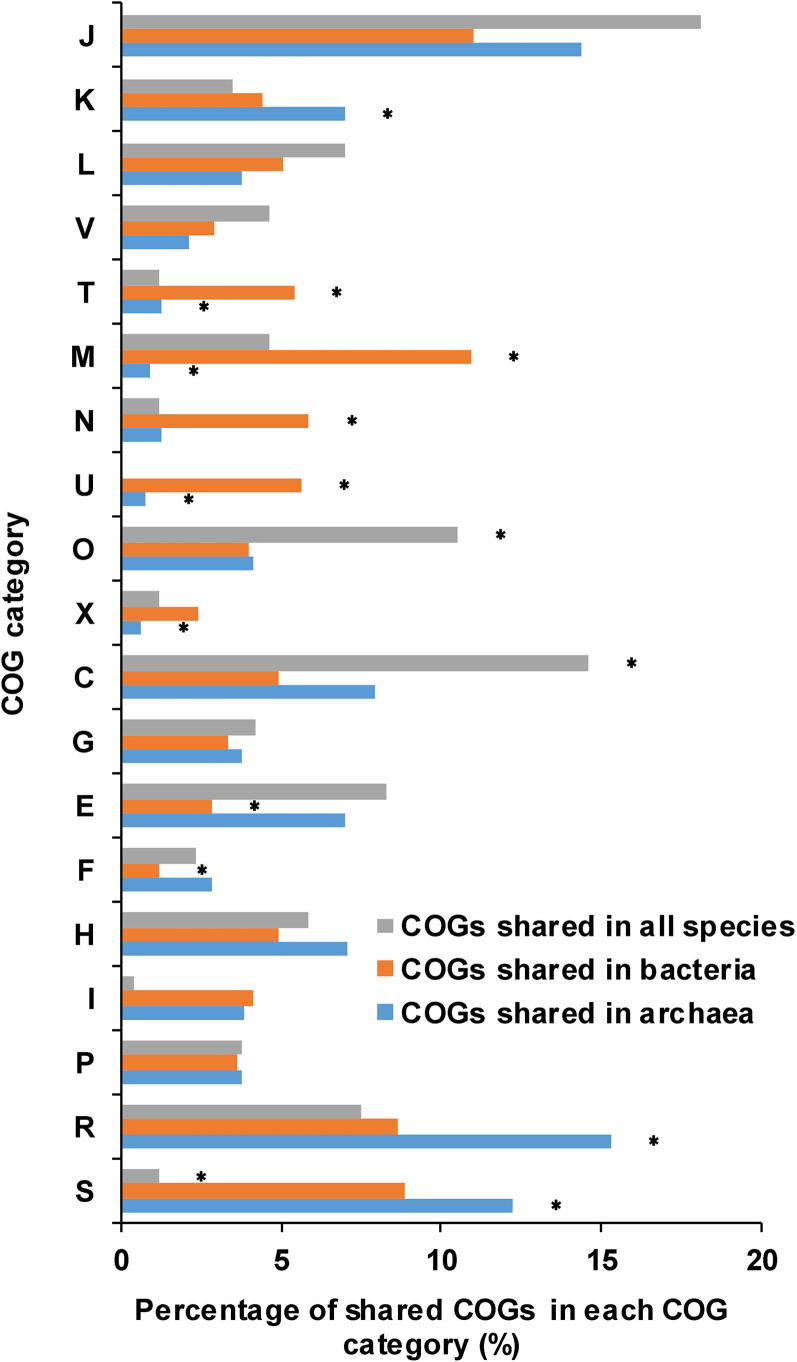
Comparison of COG distributions in AMD samplesComparisons of the distributions of COGs shared in all species, bacteria, and archaea, respectively. The vertical axis shows the different COG categories and the percentage of shared COGs in each category is shown on the horizontal axis. Asterisks indicate that the enrichments are significant (Fisher’s exact test, P < 0.05). COG refers to Clusters of Orthologous Groups. The COG categories are listed as follows. J, translation, ribosomal structure and biogenesis; K, transcription; L, replication, recombination and repair; V, defense mechanisms; T, signal transduction mechanisms; M, cell wall/membrane/envelope biogenesis; N, cell motility; U, intracellular trafficking, secretion, and vesicular transport; O, posttranslational modification, protein turnover, chaperones; X, mobilome: prophages, transposons; C, energy production and conversion; G, carbohydrate transport and metabolism; E, amino acid transport and metabolism; F, nucleotide transport and metabolism; H, coenzyme transport and metabolism; I, lipid transport and metabolism; P, inorganic ion transport and metabolism; R, general function prediction only; S, function unknown.